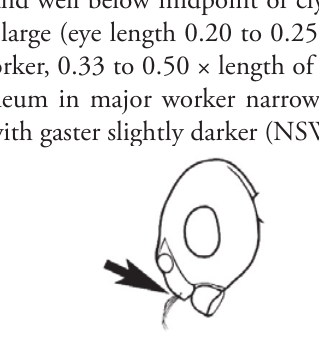
– In profile, clypeal psammophore placed just below midpoint to above